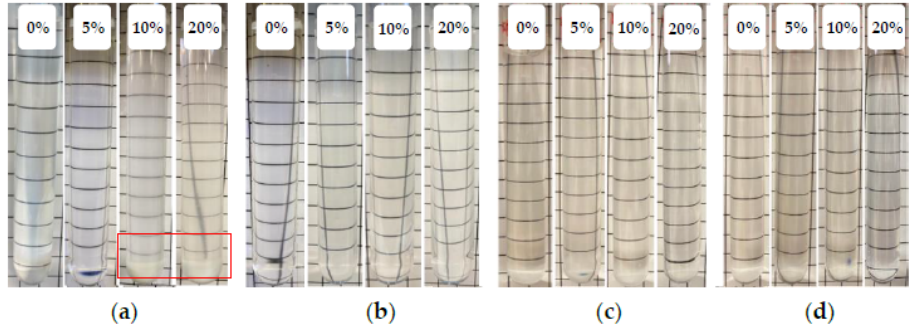
Figure 2. The appearance of surfactant solutions at 0, 5, 10 and 20 wt% NaCl concentrations after 30 days at 293 K: ( a ) SDS; ( b ) NP12EO, ( c ) NP12EO-SA; ( d )